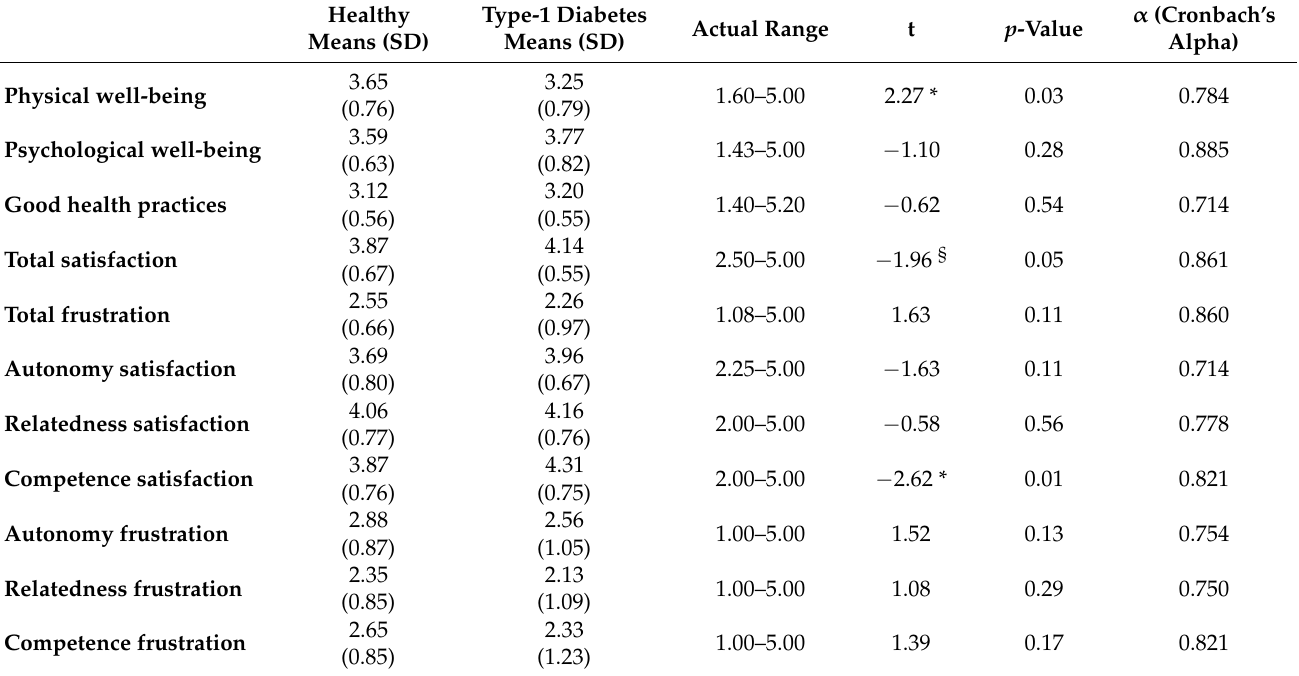
Table 2. Descriptive statistics of research variables followed by group